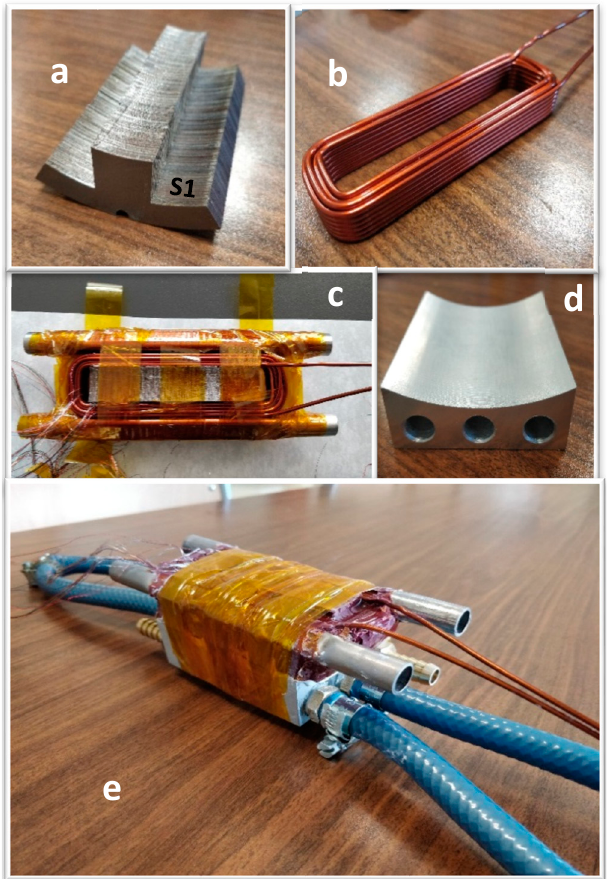
Figure 14. Construction of the segmented stator winding set-up used for the validation of the numerical results: ( a ) one tooth segment of the stator of a SR machine; ( b ) form coil used as the winding; ( c ) form coil placed on the tooth along with two triangular tubes for direct coil cooling, ready to be impregnated with epoxy resin; ( d ) water jacket for the set-up; ( e ) the epoxy impregnated segmented stator winding set-up together with the water jacket.